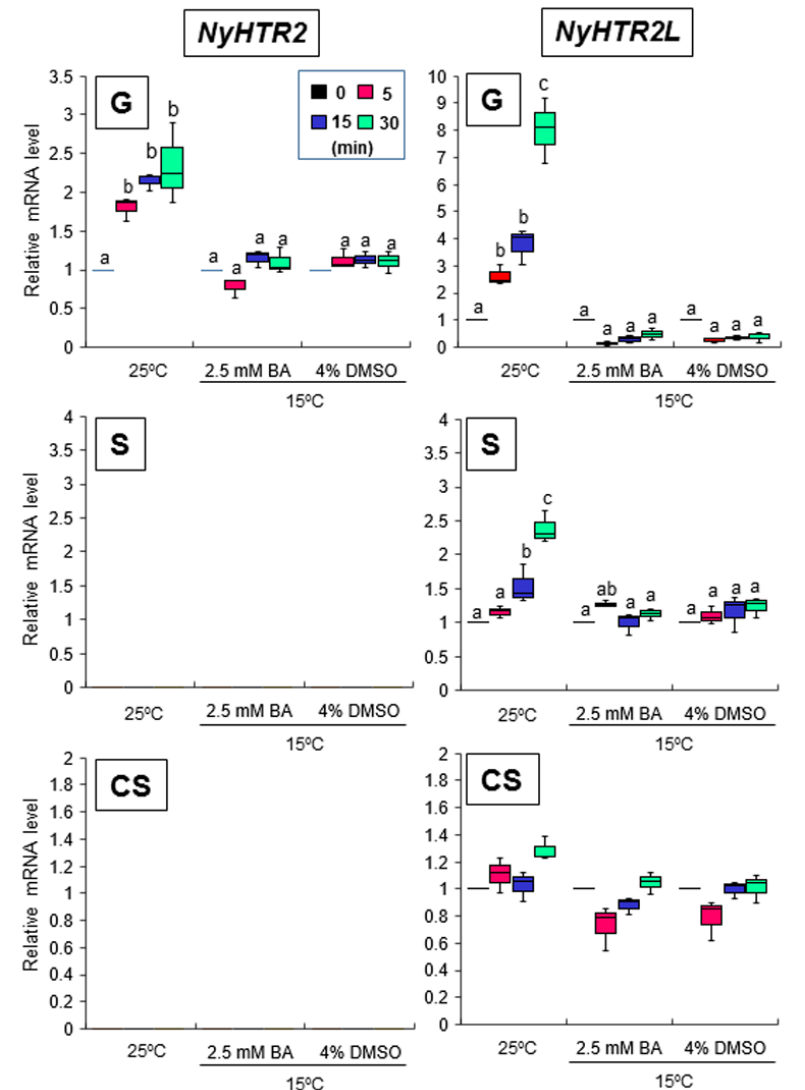
Figure 5. Effects of changes in membrane physical state on NyHTR2 and NyHTR2L expression in three life cycle generations of Neopyropia yezoensis . The algae were treated with 2.5 mM BA and 4% DMSO at 15 °C for 5, 15, and 30 min, and the expression of NyHSP70-1 and NyHSP70-2 was compared with their expression at 25 °C. Relative mRNA levels were normalized using eIF4A as the reference gene. In the box plots, values on the Y axis represent the fold change of relative quantification of each gene. Since no expression of NyHTR2 was observed in sporophyte and conchosporophyte, nothing is displayed in corresponding panels in the figure. Different alphabetical letters denote significant differences in expression level among the three life cycle generations from triplicate independent replicates as defined by Tukey’s test ( p < 0.05) in two-way ANOVA. G—gametophyte; S—sporophyte; CS—conchosporophyte.